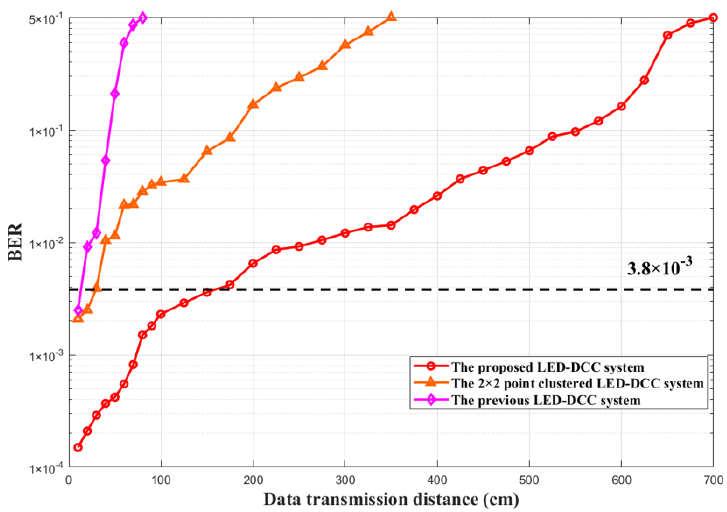
Figure 7. The BER performance of different LED-DCC systems versus data transmission